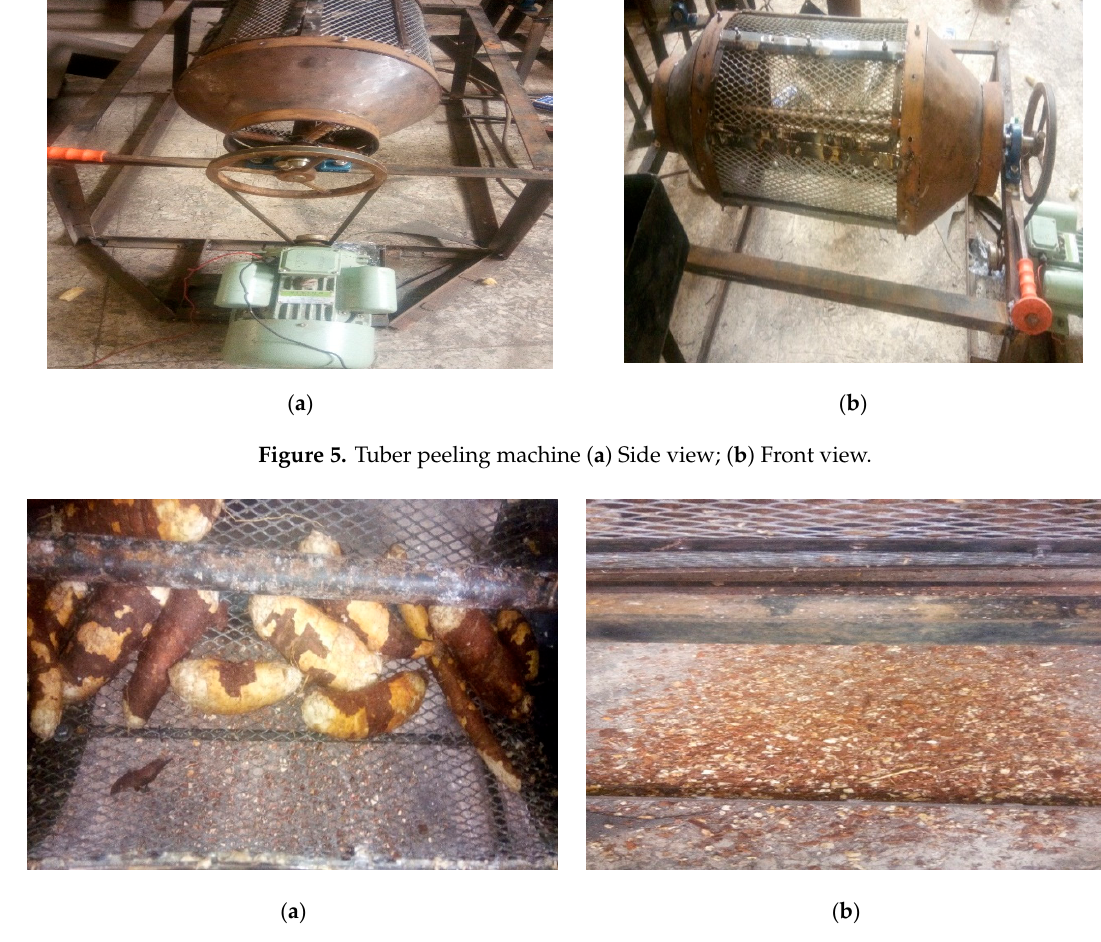
Figure 6. ( a ) Peeled cassava tubers; ( b ) cassava peels.